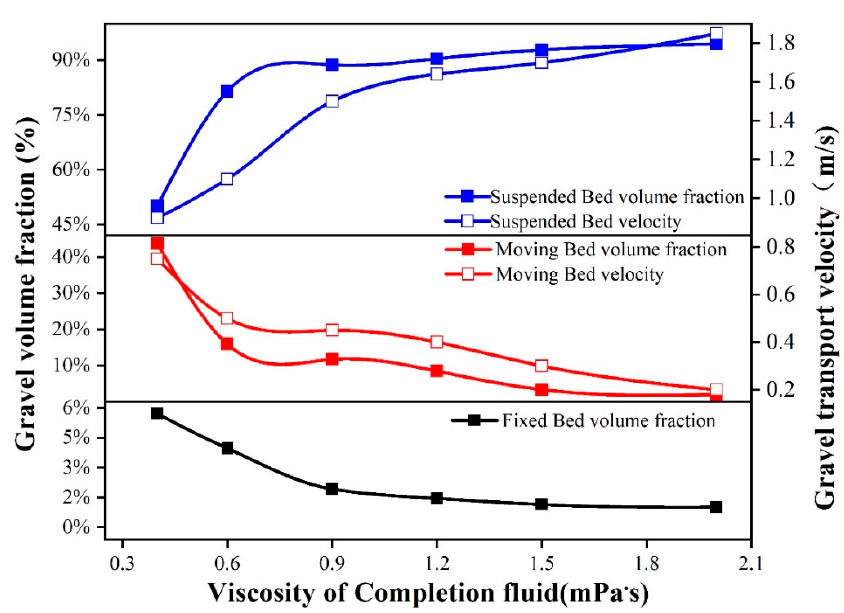
Figure 12. Graph of the effect of carrying-fluid viscosity on the volume fraction and transport velocity.